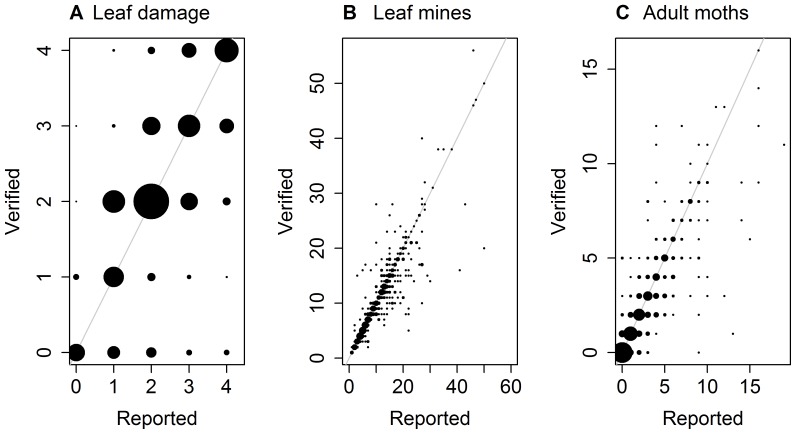
Accuracy of reported counts of (A) leaf damage, (B) leaf mines and (C) adult moths.The area of the circles is proportional to the frequency of reports. The maximum circle size represents 1233, 20 and 178 records for A, B and C, respectively. The 1∶1 line is shown in grey.